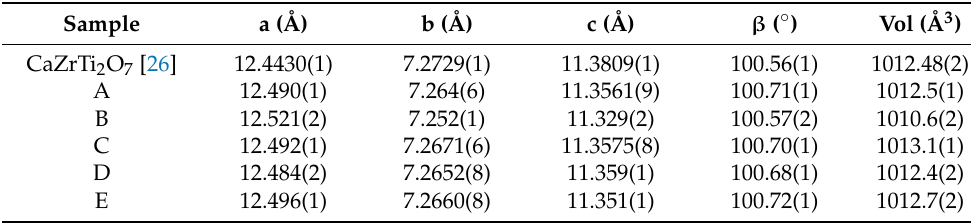
Table 3. The unit cell parameters of zirconolite-2M formed in Samples A–E